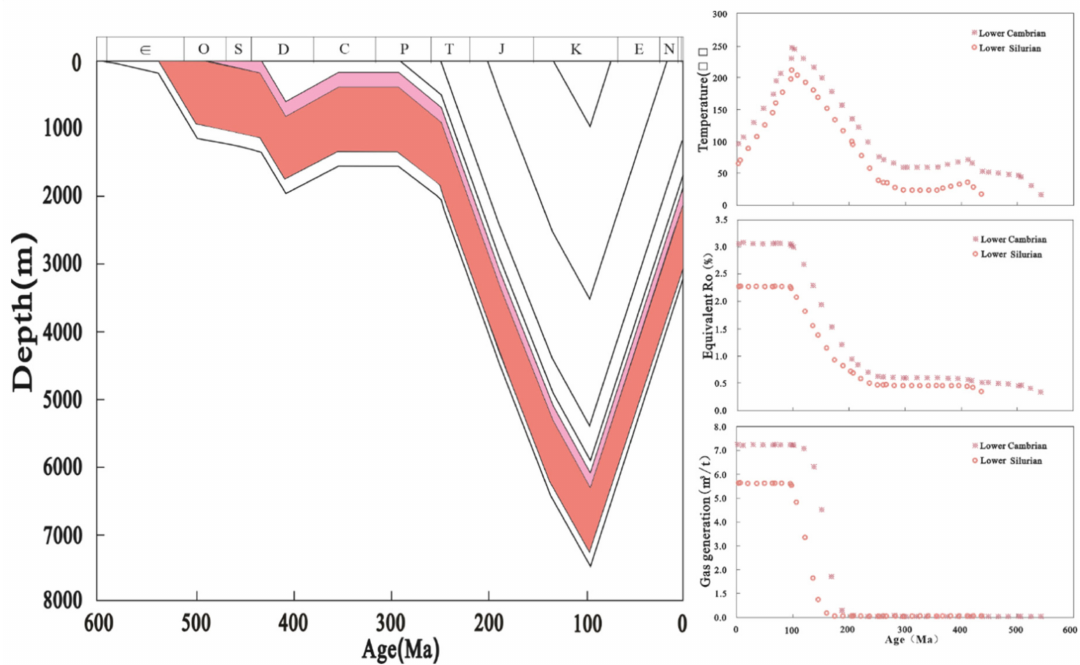
Figure 7. Plots of the burial history and thermal evolution of the Silurian Longmaxi shales in the Weiyuan area (Well W117). The thermal gradient evolution history was established by the reflectance inversion method: 32 ◦ C / km ( > 96 Ma), 30 ◦ C / km (96–65 Ma), 27 ◦ C / km ( < 65 Ma). The thermal evolution histories of Lower Silurian shale were reconstructed by combining the thermal gradient model and their burial histories